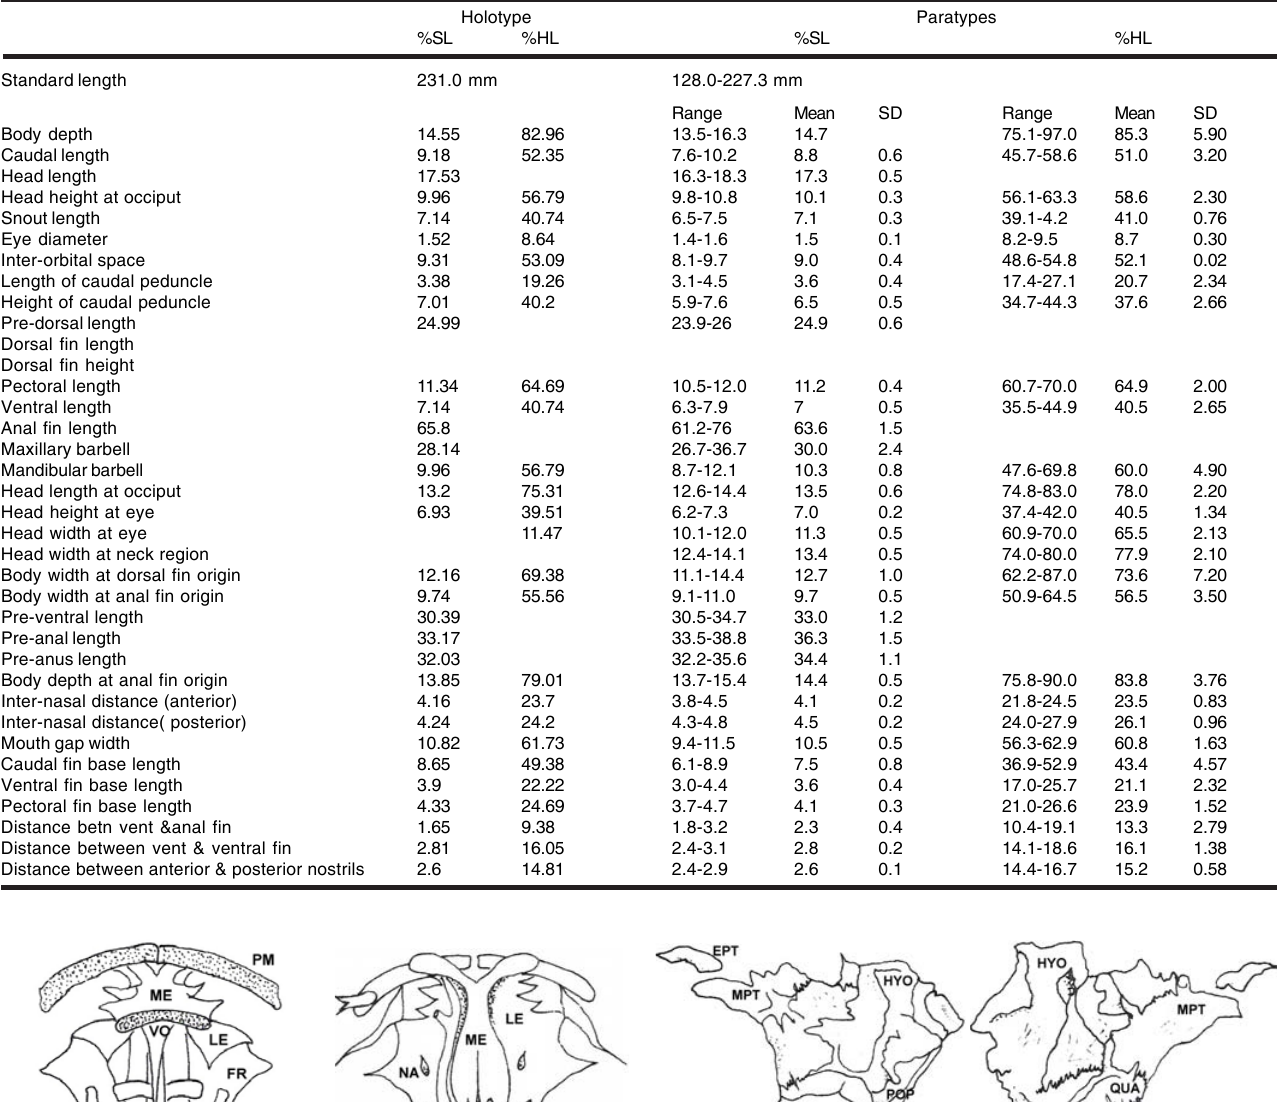
Table 1. Morphometric data of Pterocryptis